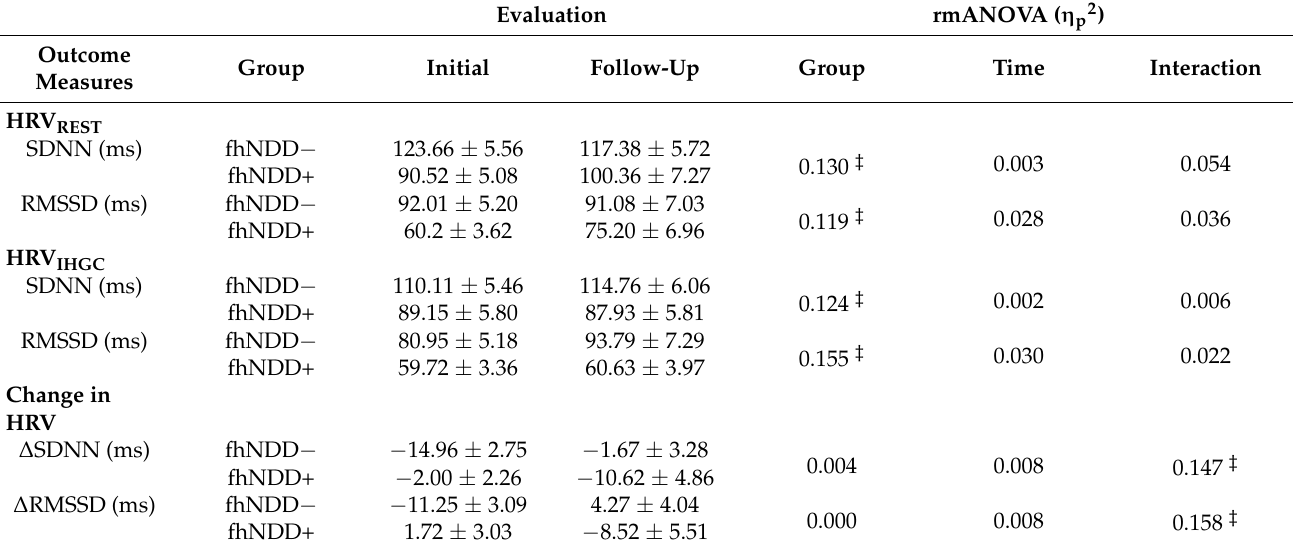
Figure 4. Group comparisons of HRV between those with a family history of neurodegenerative disease (fhNDD+; light gray) and without a family history of neurodegenerative disease (fhNDD − ; dark gray) during self-paced breathing/resting- state assessment at each evaluation. ( A ) SDNN. ( B ) RMSSD. ( C ) LF power (natural logarithmic units). ( D ) HF power (natural logarithmic units). * p < 0.05. Table 4. Descriptive statistics for HRV during the 1-min resonant breathing assessments at each